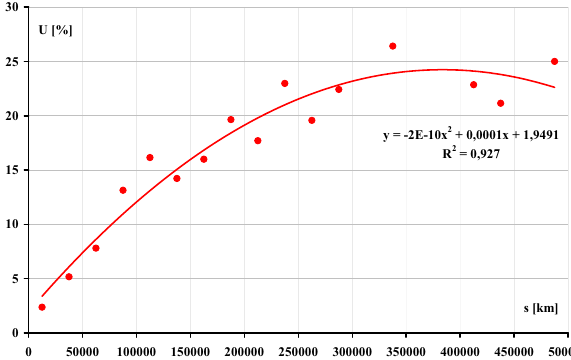
Figure 2: Dependence of the frequency of vehicle faults on the road mileage.